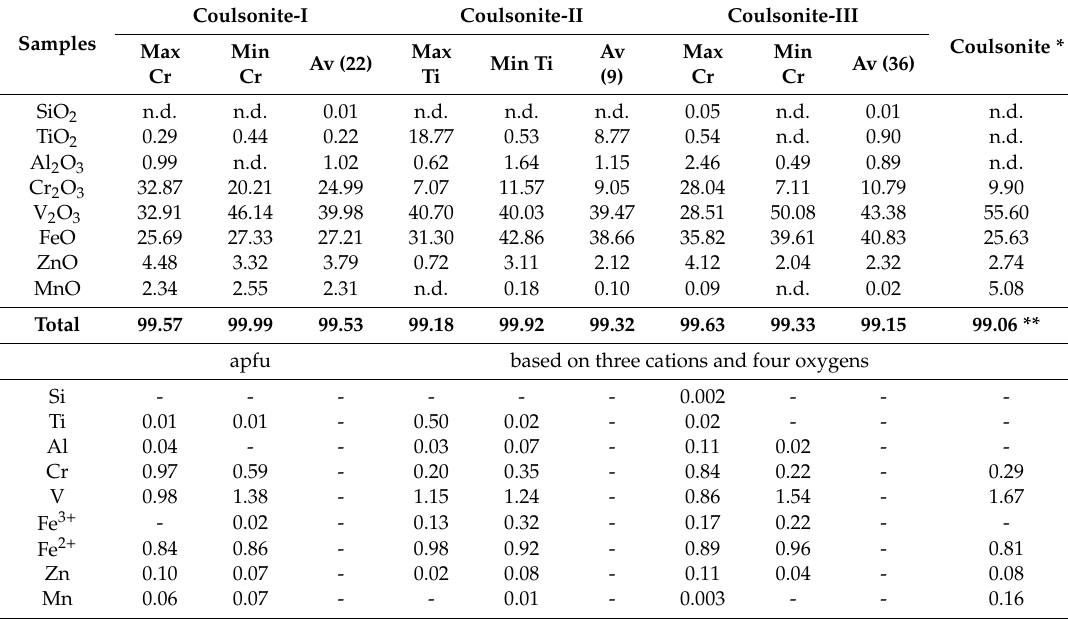
Table 2. Chemical composition (Wavelength Dispersive Spectrometer (WDS), wt.%) of coulsonite from the massive sulfide ore of the Kola region.